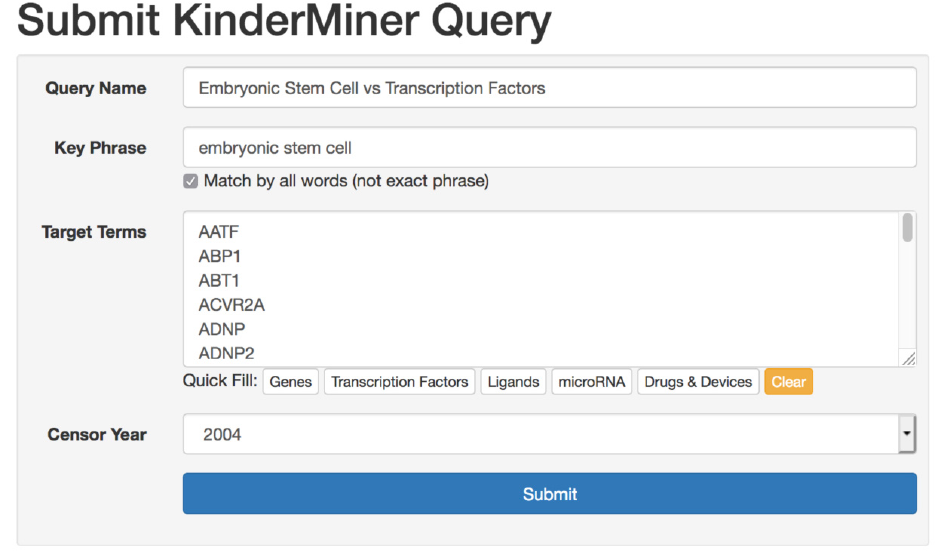
Figure 2. Users enter a search for a particular key phrase and list of target terms.